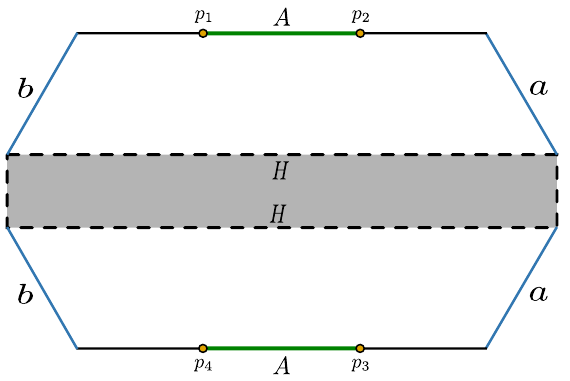
Figure 1 . Diagram depicts a constant time slice of an eternal AdS 3 BTZ black hole (the grey shaded region in the figure) truncated by two Karch-Randall (KR) branes namely a and b branes. At the asymptotic boundaries of the bulk BTZ black hole, two copies of BCFT 2 s are located which constitute a TFD state. Each of the BCFT 2 s lives on a manifold with two boundaries where the boundary points p I = r I = 1 and p O = r O = 2 contain different boundary conditions b and a respectively. The dotted line in the figure denoted by H describes the horizon of the bulk eternal AdS 3 BTZ black hole. An interval A = [ p 1 ,p 2 ] ∪ [ p 3 ,p 4 ] in the two copies of the BCFT 2 s is also shown in the diagram. (Figure modified from [23,